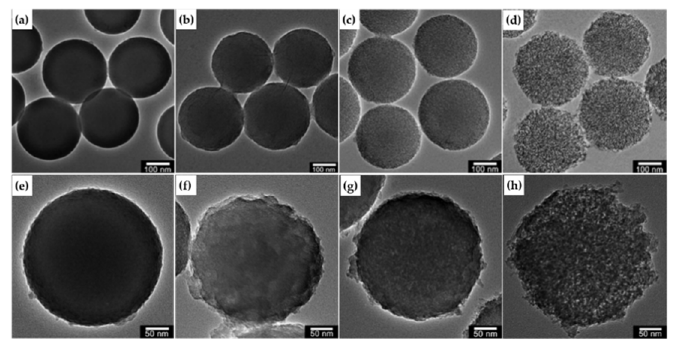
Figure 3. TEM images of ( a ) nSiO 2 , ( b ) p1SiO 2 , ( c ) p2SiO 2 , ( d ) epSiO 2 , ( e ) GO/nSiO 2 , ( f ) GO/p1SiO 2 , ( g ) GO/p2SiO 2 , and ( h ) GO/epSiO 2 . [59].